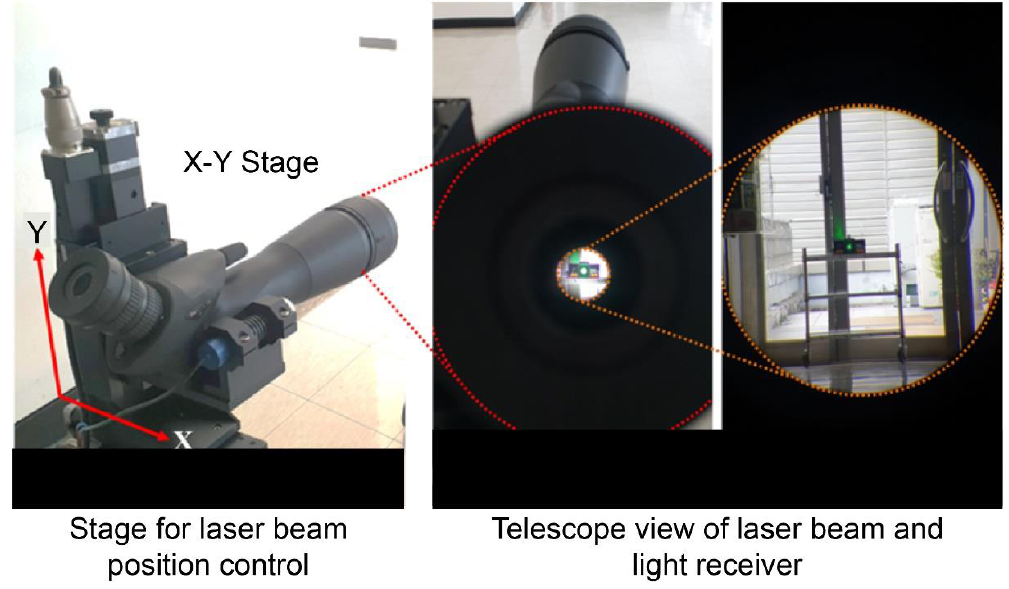
Figure 4. Motorized Stage along the X- and Y-axes and telescope of light source part .